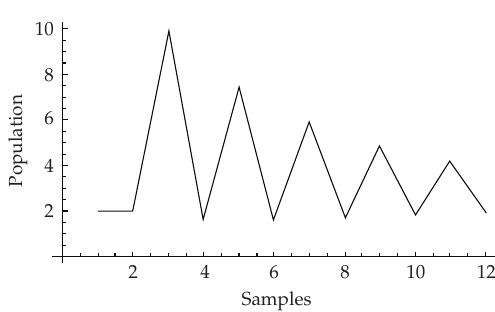
Figure 6: μ (cid:8) 2 , K (cid:8) 200 , γ (cid:8) 0 . 4 , d (cid:8) 0 . 1 x (cid:2) 0 (cid:3) , α (cid:8) 0 . 1 , p (cid:8)